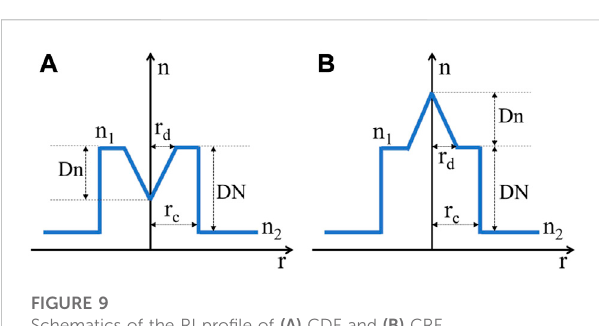
FIGURE 9 Schematics of the RI pro fi le of (A) CDF and (B)